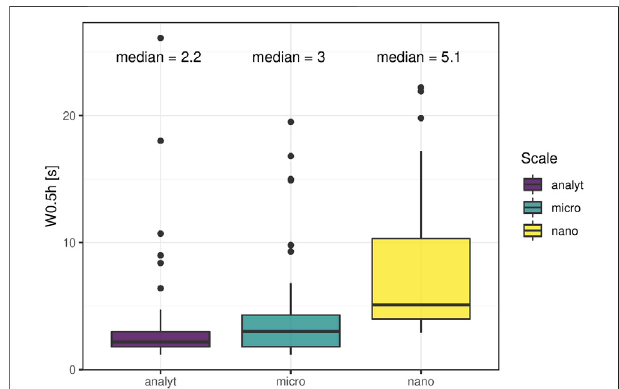
FIGURE1| Peakwidth. Fullwidthat halfmaximum wasassessed for53 molecules comprising endogenous (ceftiofur and coumaphos 10 μ g/L, caffeine, paraxanthine and theobromine at naturally occurring abundance; all others 1 μ g/L) molecules in plasma extract. Lysophospholipids were broader compared to the rest in all setups. Further, thiophosphate, sulfonamide/sulfonate and nitrate-containing compounds had distorted peak shapes in the nano